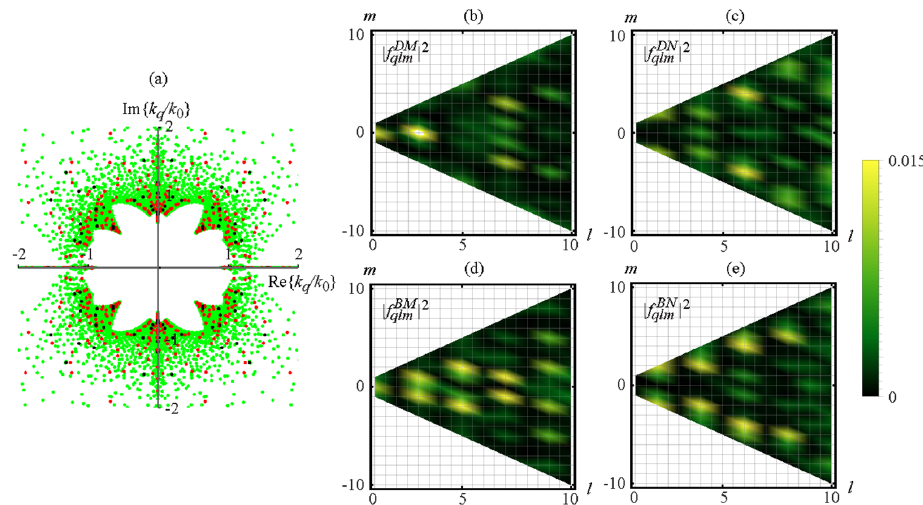
Figure 2. ( a ) Inverse eigenvalues k q / k 0 of the eigenproblem in Equation (10) truncated at l = 4 (black dots), 10 (red dots), and 40 (green dots). Note the correspondence with the eigenvalues of the index of refraction’s operator plotted in Figure 1b; ( b – e ) eigenvector components (cid:3627)𝑓 (cid:3044)(cid:3039)(cid:3040) (cid:3627) eigenproblem in Equation (10) for a bianisotropic orbital with k q / k 0 = 2.2 in the angular momentum space l - m .